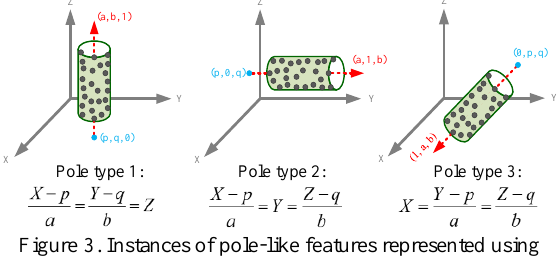
Figure 3. Instances of pole-like features represented using the proposed models